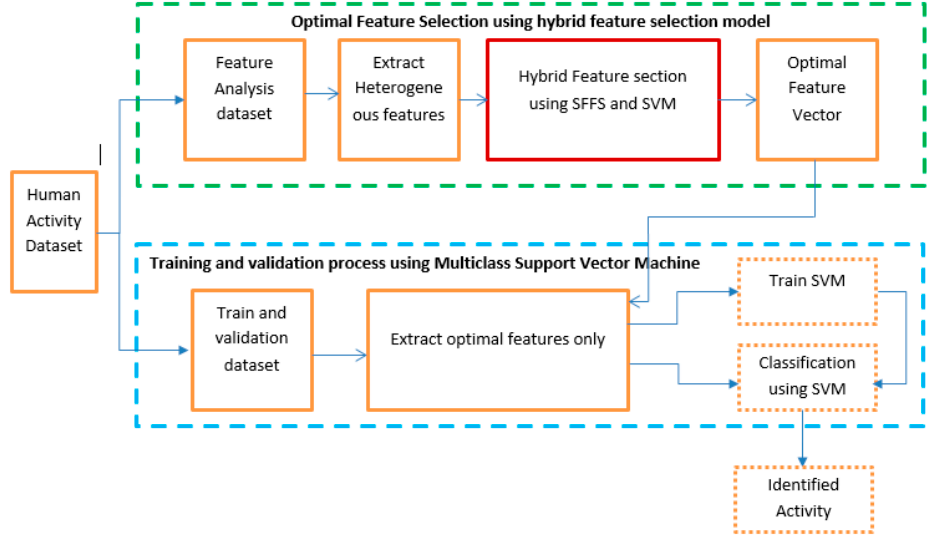
Figure 1. Structure of the proposed model of activity identification.